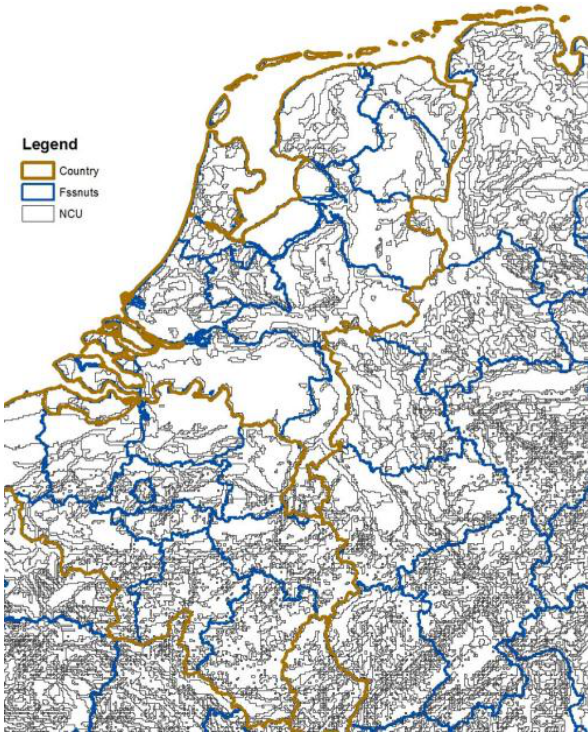
1 Fig. 2. Map of the Netherlands depicting the NCU, FSSNUTS, and Figure 2. Map of the Netherlands depicting the NCU, FSSNUTS, and Country spatial 2 Country spatial aggregation levels. aggregation levels. 3 4